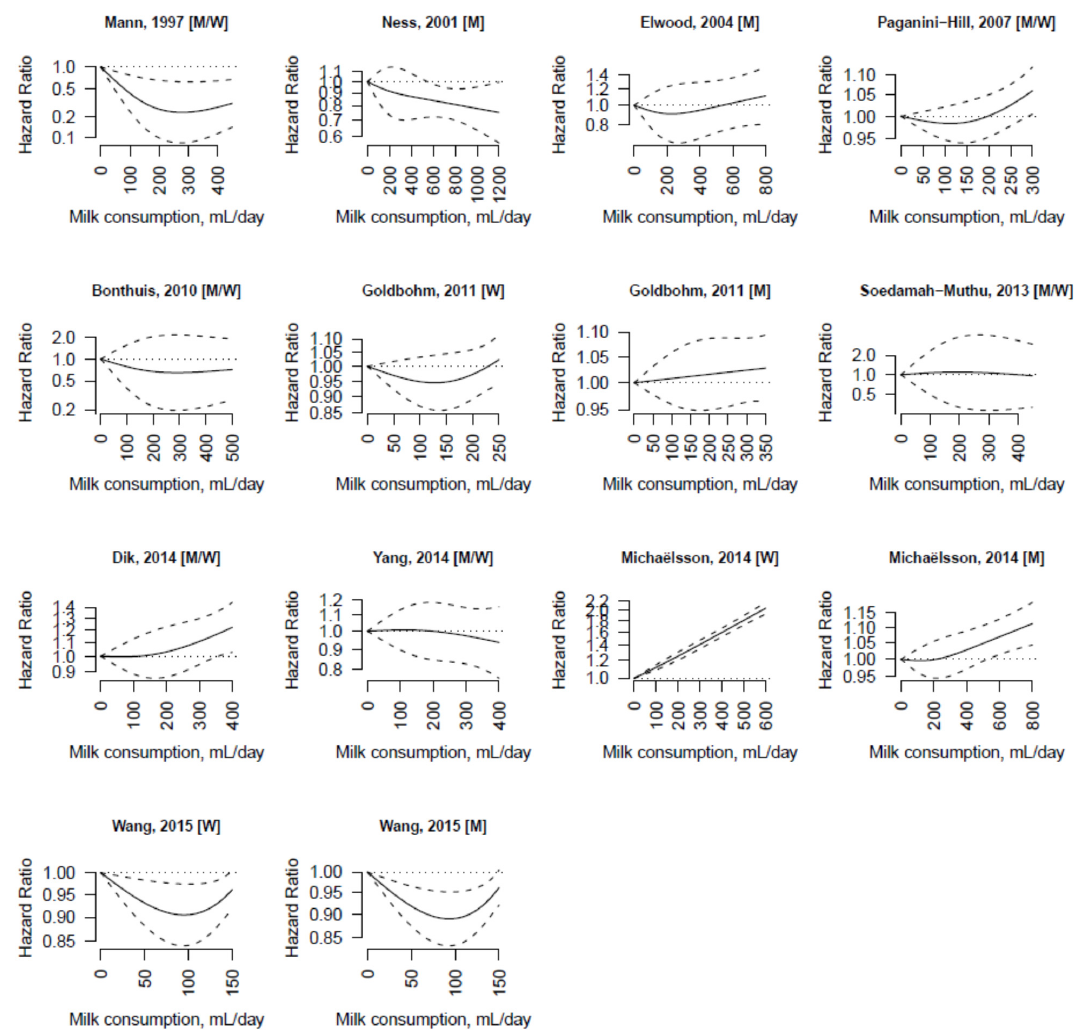
Figure 2. Dose-response association between non-fermented milk consumption and all-cause mortality in individual studies. The hazard ratios are plotted on a log scale.